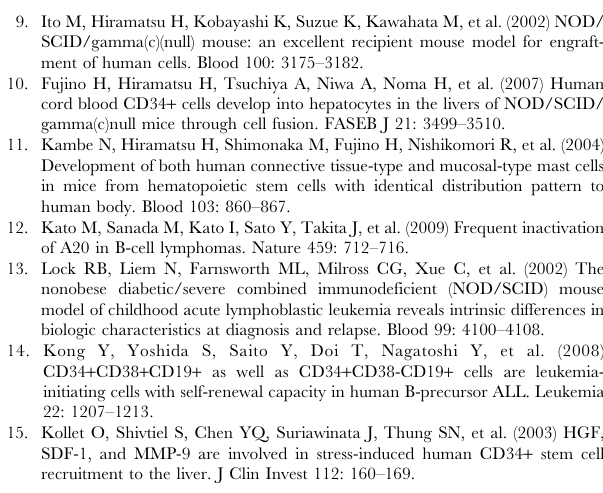
Figure S3 The actual interaction between CXCR4 on leukemic cells and SDF1. Representative images of Proximity Ligation Analysis (PLA) detected by the Duolink Detection kit (Olink Bioscience, Uppsala, Sweden). The system elicits a visible signal only when the two antibodies (i.e. anti-SDF-1 and anti- CXCR4) are in close proximity. Arrows denote regions of signal amplification indicating the actual interaction between SDF-1 and CXCR4. Nuclear stain is DAPI (Blue). Scale bar indicates 50 m m. Figure S4 The checker board assay. Increasing concentrations of SDF-1 a were added to upper or lower compartments of migration chambers. Significant increases in numbers of migrating cells were observed when reagent was added to lower chambers. Baseline was defined as result of assay without SDF-1 a .